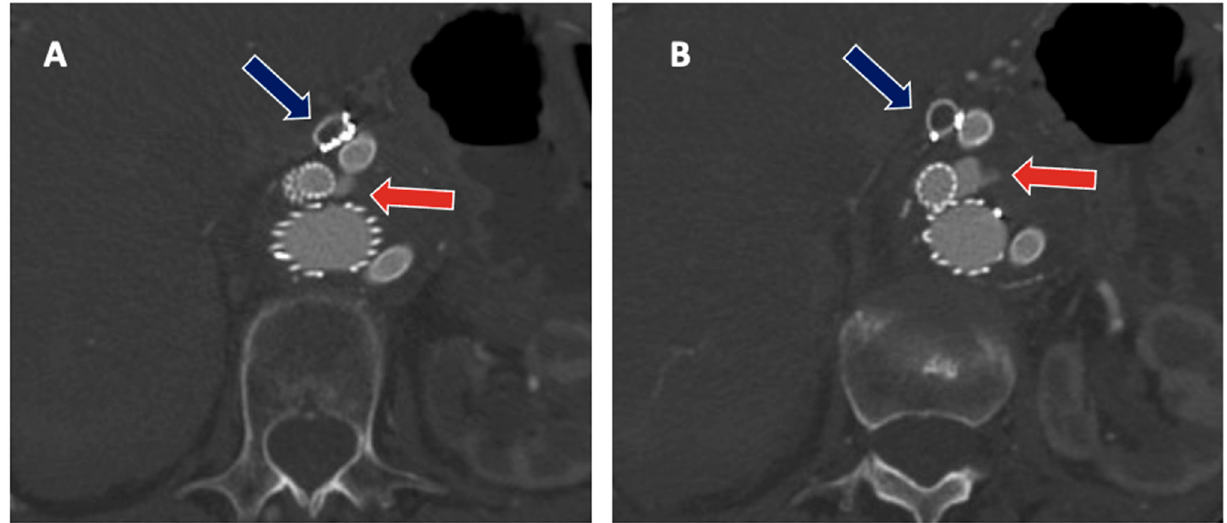
Figure 3. ( A , B ) Type IIIb endoleak from the right renal stent (red arrow), with sac enlargement and simultaneous asymptomatic thrombosis of the celiac trunk stent ‐ graft (blue arrow).